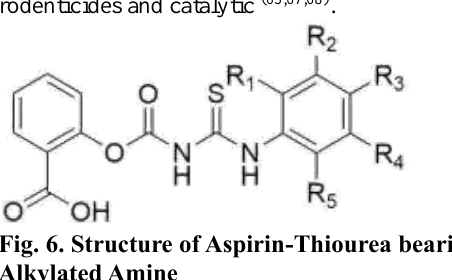
Fig. 6. Structure of Aspirin-Thiourea bearing Alkylated